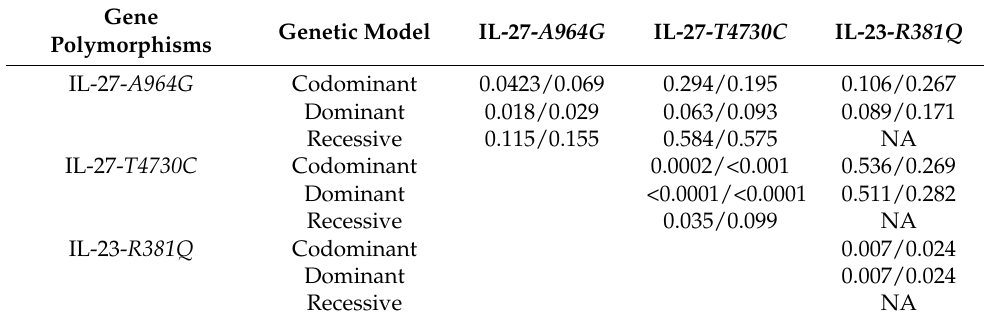
Table 4. Association analysis of SNP-SNP interactions with odds of